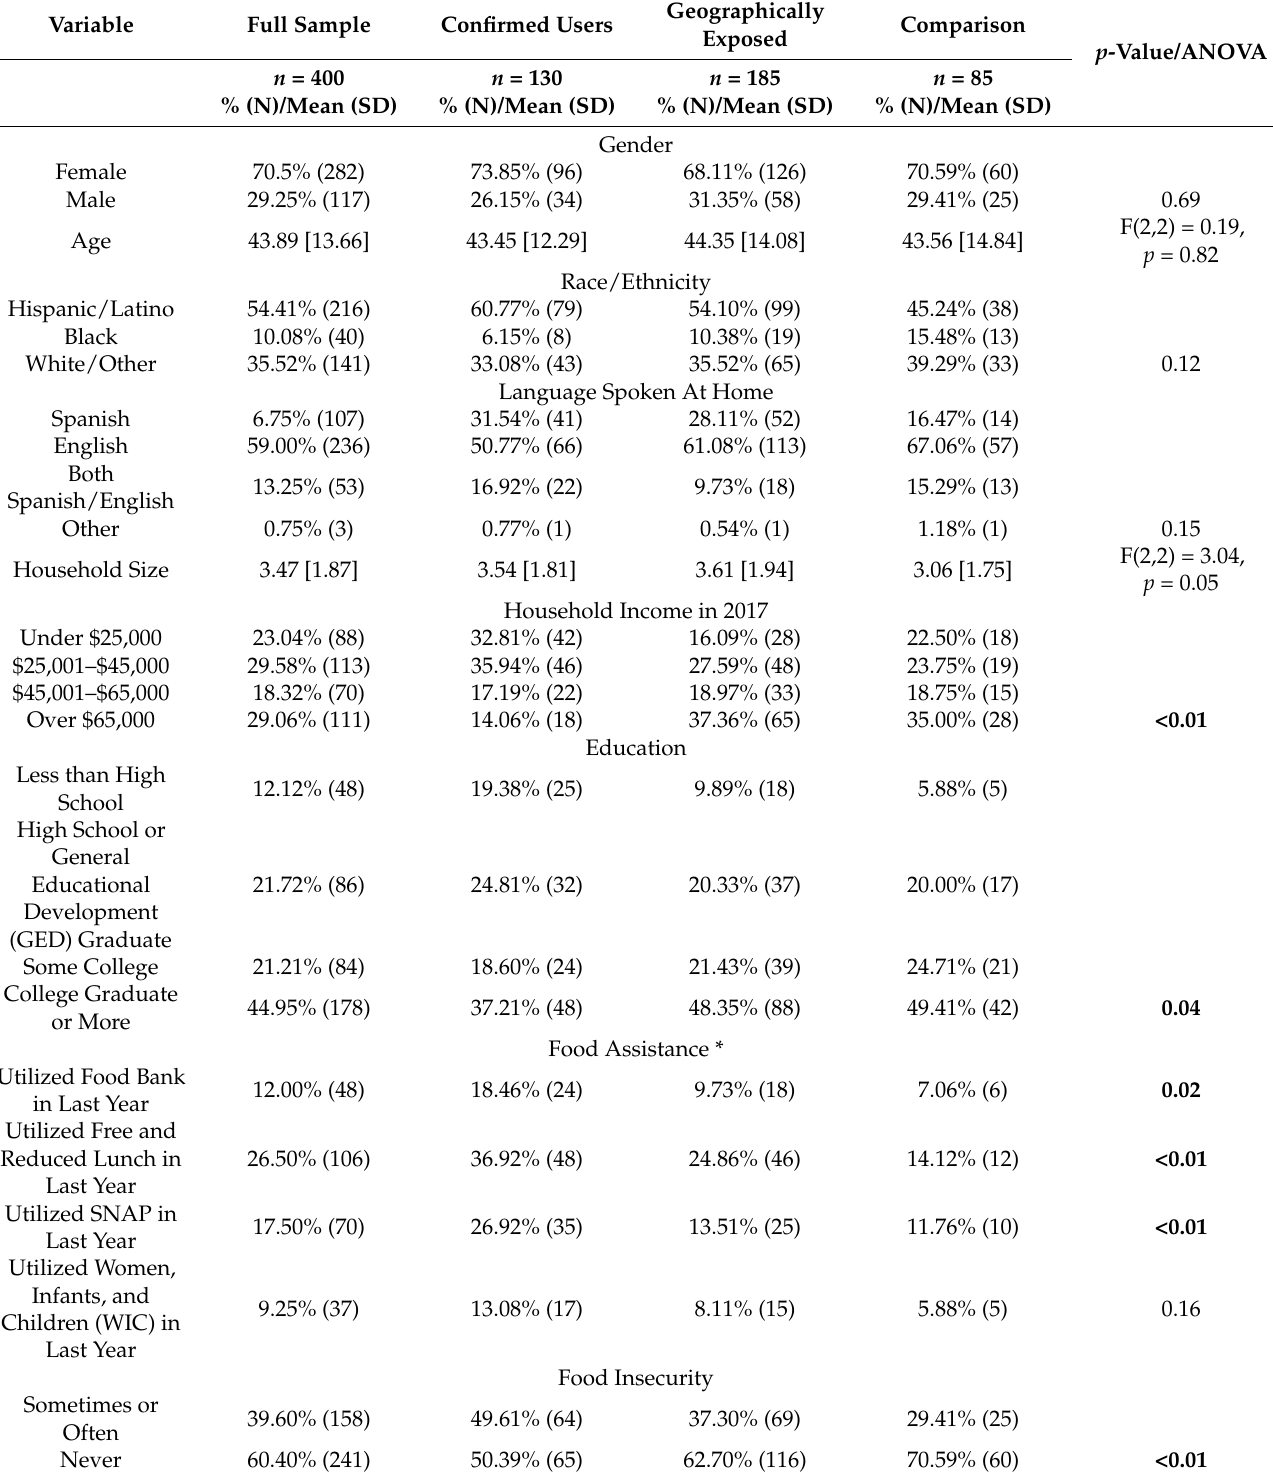
Table 2. Descriptive statistics of sociodemographic characteristics stratified by recruitment strategy among adults at